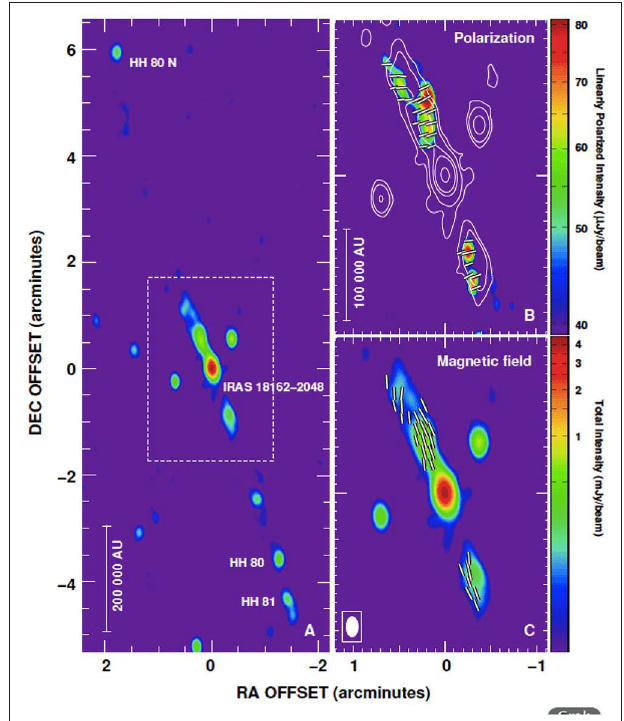
FIGURE 4 | High resolution, 6 cm radio continuum VLA images of the jet HH80-81. The knots, 0.5 pc from the source are linearly polarized indicating non-thermal synchotron emission from the jet. (A) Radio continuum image of the whole jet. (B) Linearly polarized continuum intensity image. (C) Apparent magnetic field directions superimposed on continuum map. From Carrasco-González et al. (2010) reproduced with permission c (cid:13)